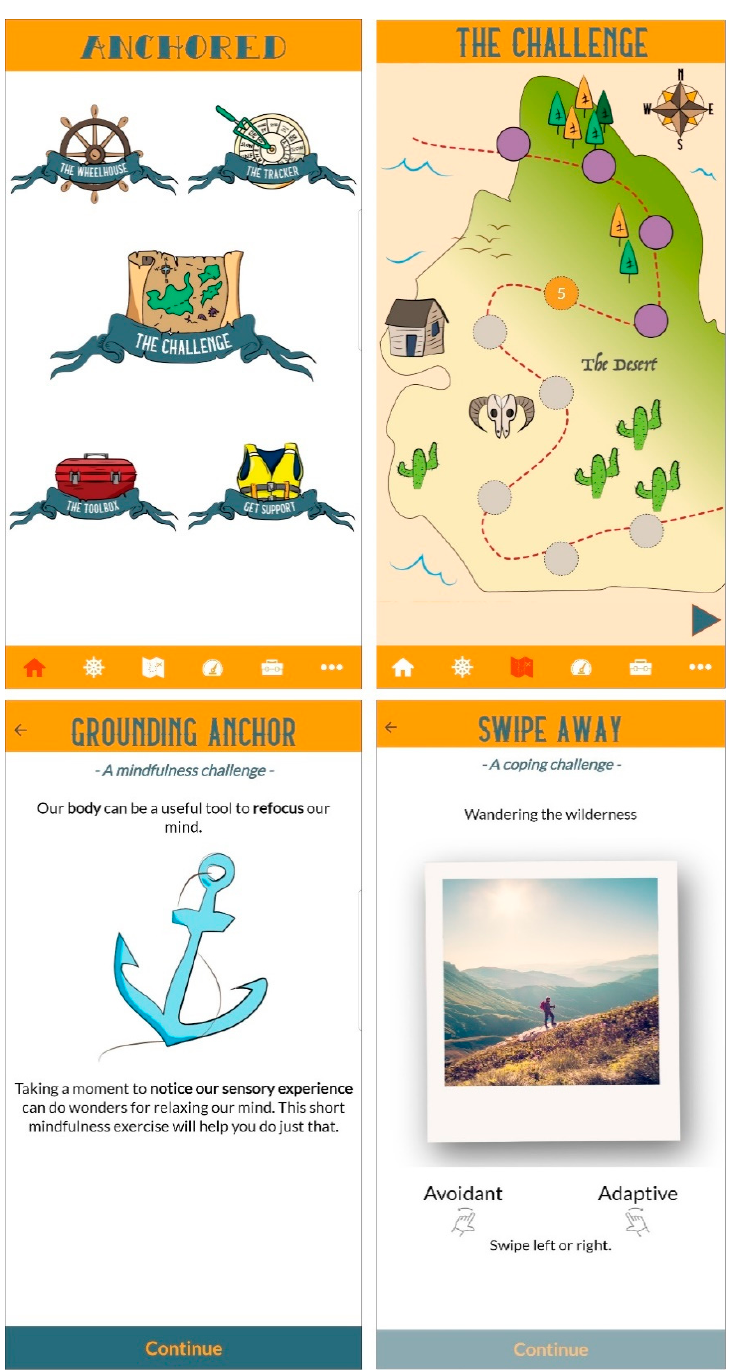
Figure 1. Screenshots from the Anchored app showing home screen ( top left ), challenge map ( top right ), and examples of challenge exercises ( bottom left and right ).